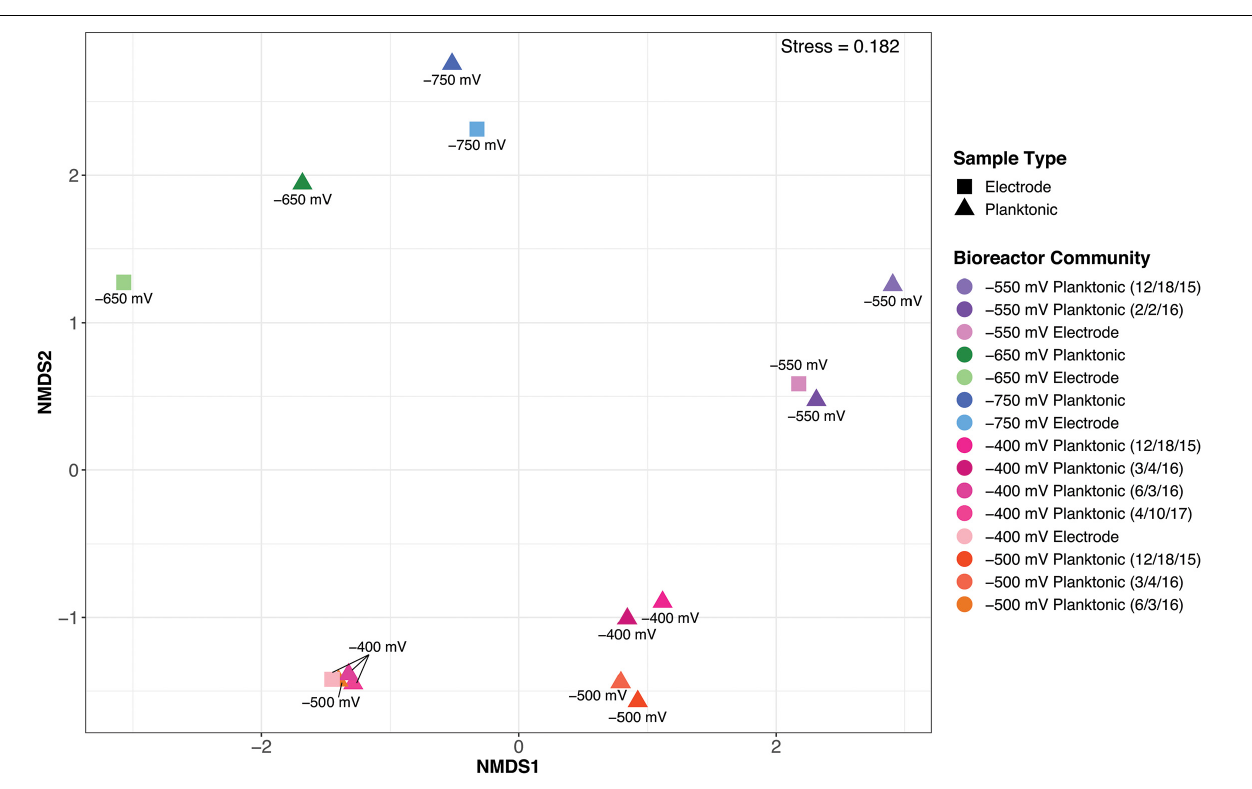
FIGURE 3 | Bray-Curtis based non-metric multidimensional scaling (NMDS) plot of the electrochemical bioreactor community samples. Squares represent electrode biofilm samples and triangles signify planktonic